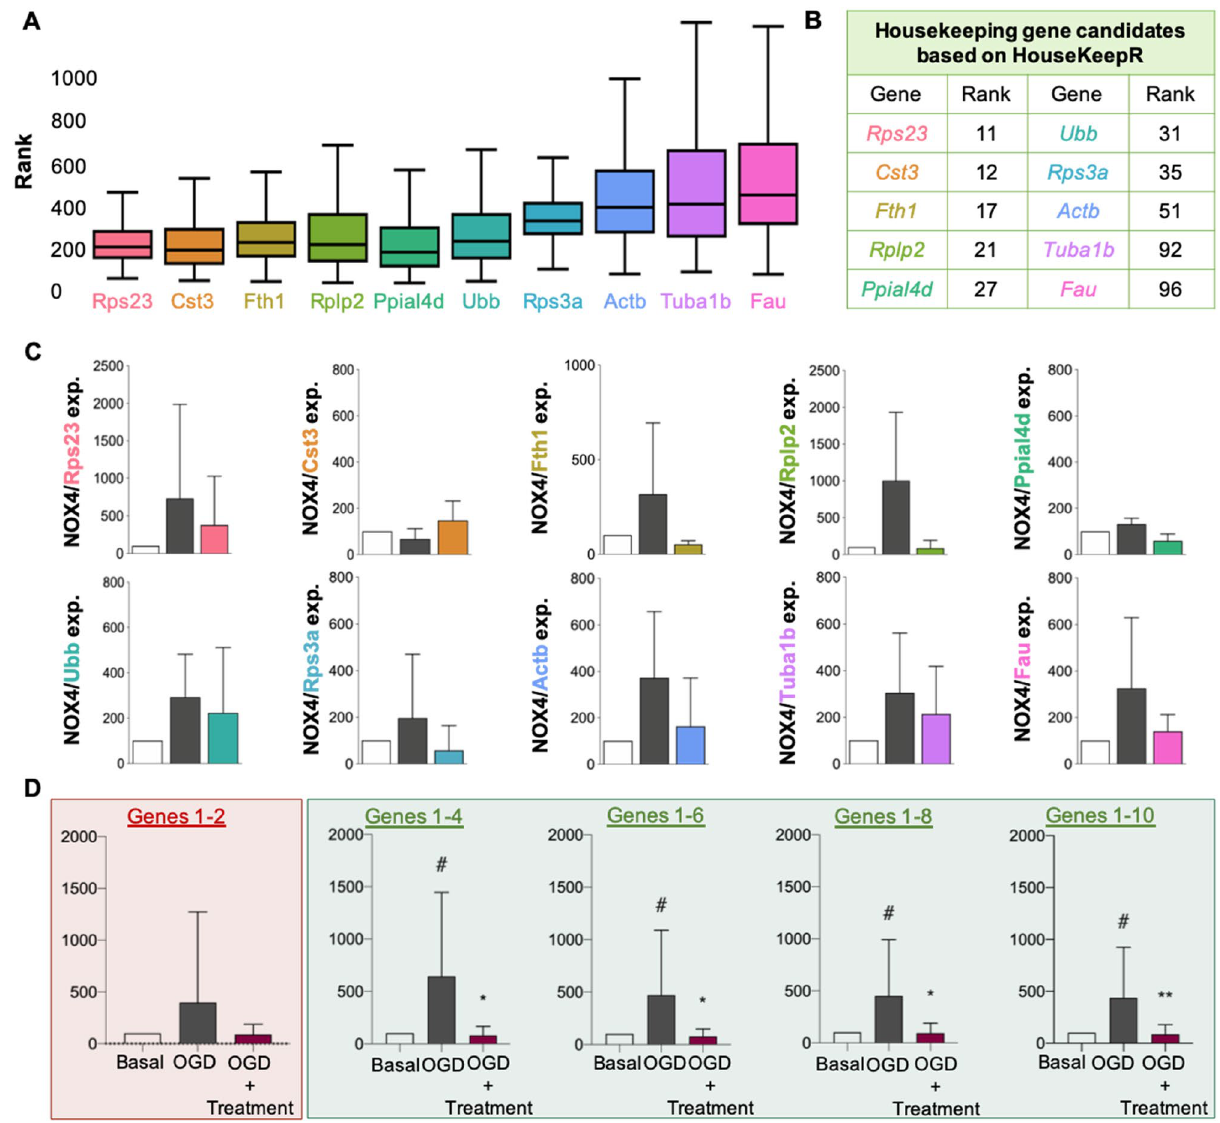
Figure 4. Un-biased de novo housekeeping gene panel generation and validation. ( A ) Ranking distribution of 10 randomly selected housekeeping gene candidates within the 100 top ranking generated over 10,000 bootstrap runs over all the samples in the 12 data sets selected for analysis. The order of the plot follows the final ranking in ( B ). ( B ) Final ranking of the selected normalisation gene candidates: Ubb, Fth1, Fau, Ppial4d, Cst3, Rps23, Actb, Tuba1, Rps3, Rplp2. This ranking is calculated by taking the mean bootstrap rank from A and penalising it for the absence of genes from each of the 12 data sets selected for analysis. ( C ) Nox4 gene expression was normalised against the selected 10 genes of the ranking under 3 different experimental conditions, i.e. Basal, oxygen and glucose deprivation (OGD) and pharmacologically treated hippocampal tissue post-OGD. ( D ) 5 housekeeping genes panels were generated and validated: (i) Panel 1; 2 genes ( Ubb and Fth1 ); (ii) Panel 2, 4 genes ( Ubb, Fth1, Fau and Ppial4d ); (iii) Panel 3, 6 genes ( Ubb, Fth1, Fau, Ppial4d, Cst3 and Rps23 ); (iv) Panel 4, 8 genes ( Ubb, Fth1, Fau, Ppial4d , Cst3, Rps23, Actb and Tuba 1); (v) Panel 5, 10 genes ( Ubb, Fth1, Fau, Ppial4d, Cst3, Rps23, Actb, Tuba 1, Rps3 and Rplp2 ). Panel 2, 3, 4 and 5 showed stable Nox4 gene expression results, while Panel 1 remained statistically not significant ( # p < 0.05, n = 6; n = 6; *p < 0.05, n = 6; **p < 0.01, n =